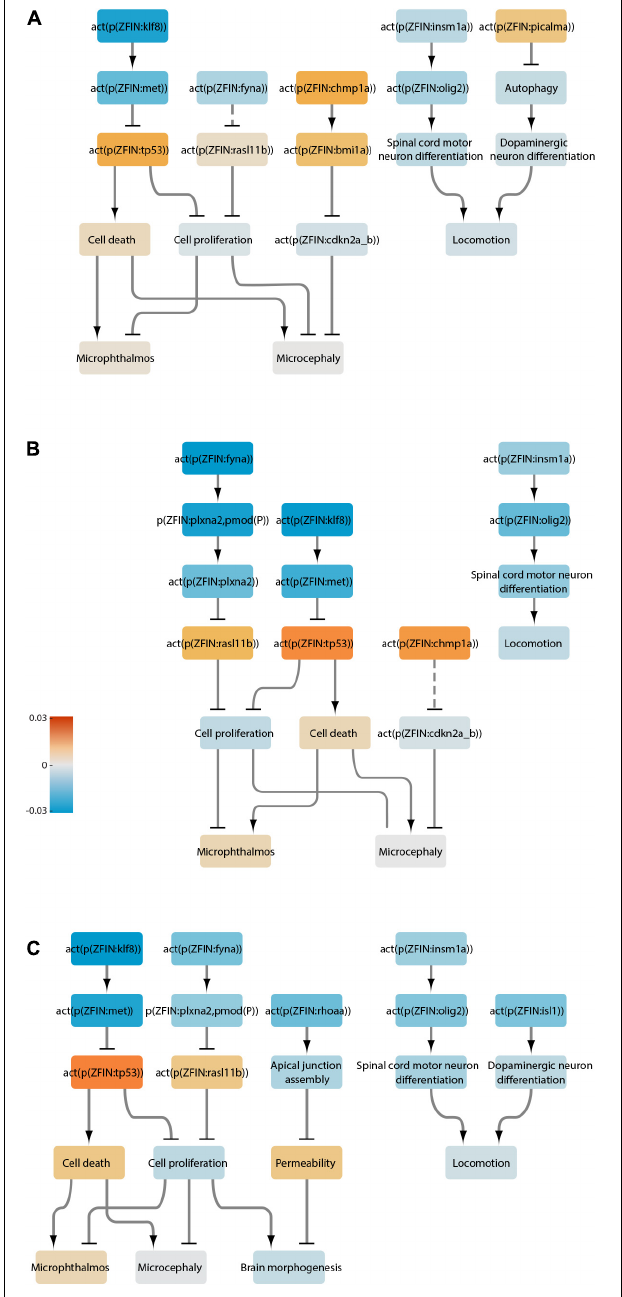
FIGURE 5 | Neurotoxicity network scored with the transcriptomes of larvae treated with selective serotonin reuptake inhibitors. (A) Sertraline treatment, 250 µ g/L. (B) Fluoxetine, 25 µ g/L. (C) Fluoxetine, 250 µ g/L. Increased and reduced activity for each node is color-coded according to the heatmap. Dotted lines represent indirect connections in the main